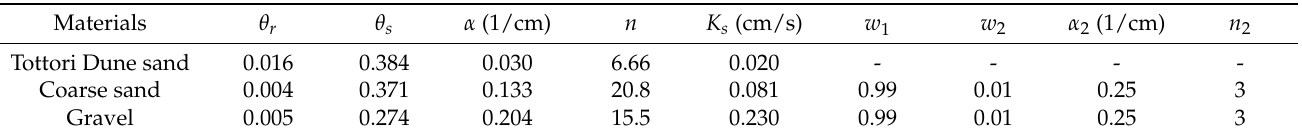
Table 1. Soil hydraulic parameters for the single-porosity (SP) and dual-porosity (DP) models for Tottori Dune sand, coarse sand, and gravel [12].